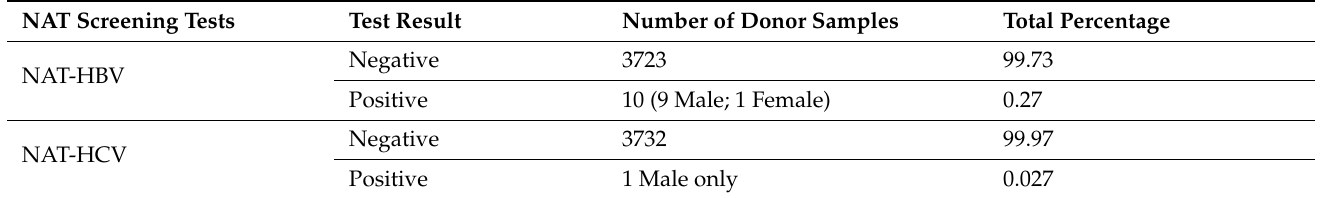
Table 3. Prevalence of a positive nucleic acid amplification test (NAT) for HBV and HBC in the blood samples of